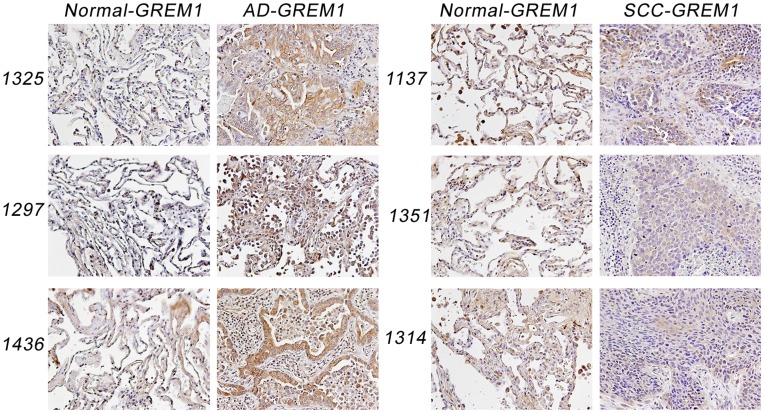
Expression of Gremlin 1 in AD and SCC tumor and normal tissues.AD and SCC tumor samples with matched normal tissue were subjected to immunohistochemical analysis using a rabbit monoclonal anti-human Gremlin antibody. Four representative pairs each of AD and SCC are depicted here. Gremlin appears to be localized in a cytoplasmic dominant manner in AD cancer cells with increased expression in comparison to matched normal tissue. SCC tumor tissue sections do not appear to overexpress Gremlin.